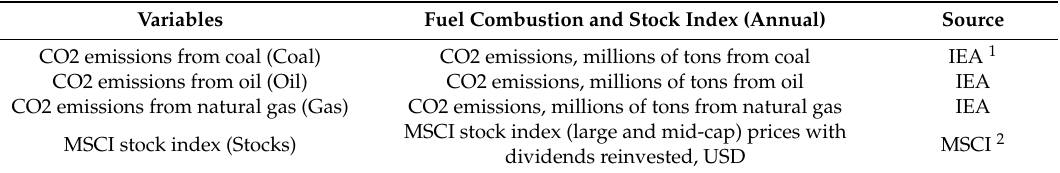
Table 1. Definitions of